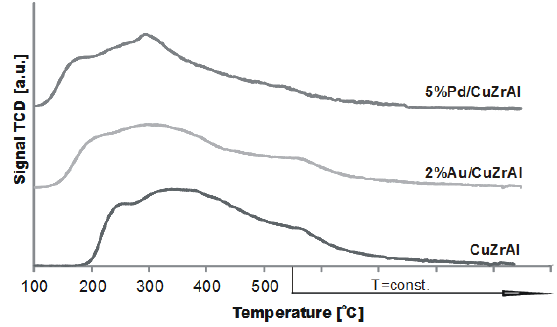
Figure 4. TPD-NH profiles for CuZrAl, 5%Pd/CuZrAl and 2% 3 Au/CuZrAl catalysts calcined in air for 4 h at